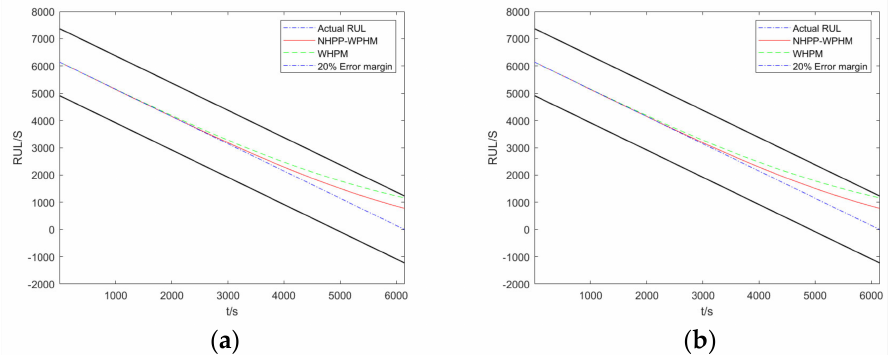
Figure 9. ( a ) RUL prediction before the first repair; ( b ) RUL prediction before the second